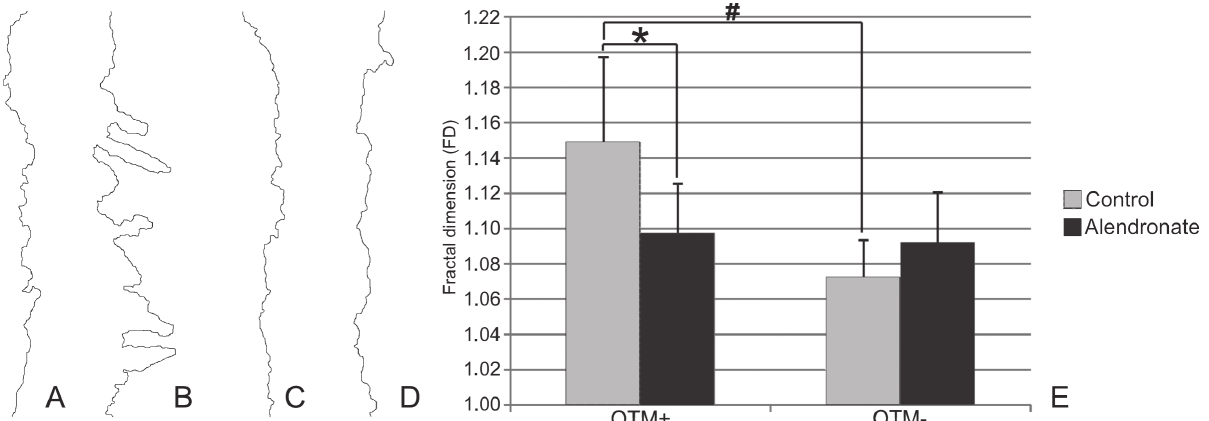
Figure 3- periodontal ligament (PDL)-bone interface outlines and fractal dimension. A: left and B: right side of a control animal; C: left and D: right side of an experimental animal. Note the increase in bone surface irregularity in the control group and almost no change in the experimental group after 21 days of induced tooth movement; E: values represent the mean ±SD (standard deviation) of